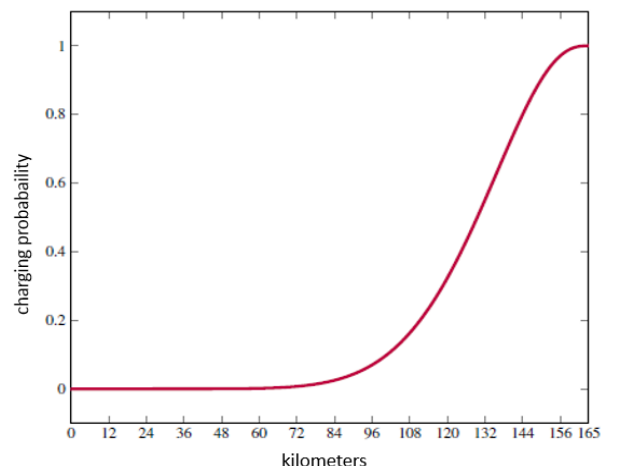
Figure 3. Charging probability depending on kilometers to drive with remaining range of 165